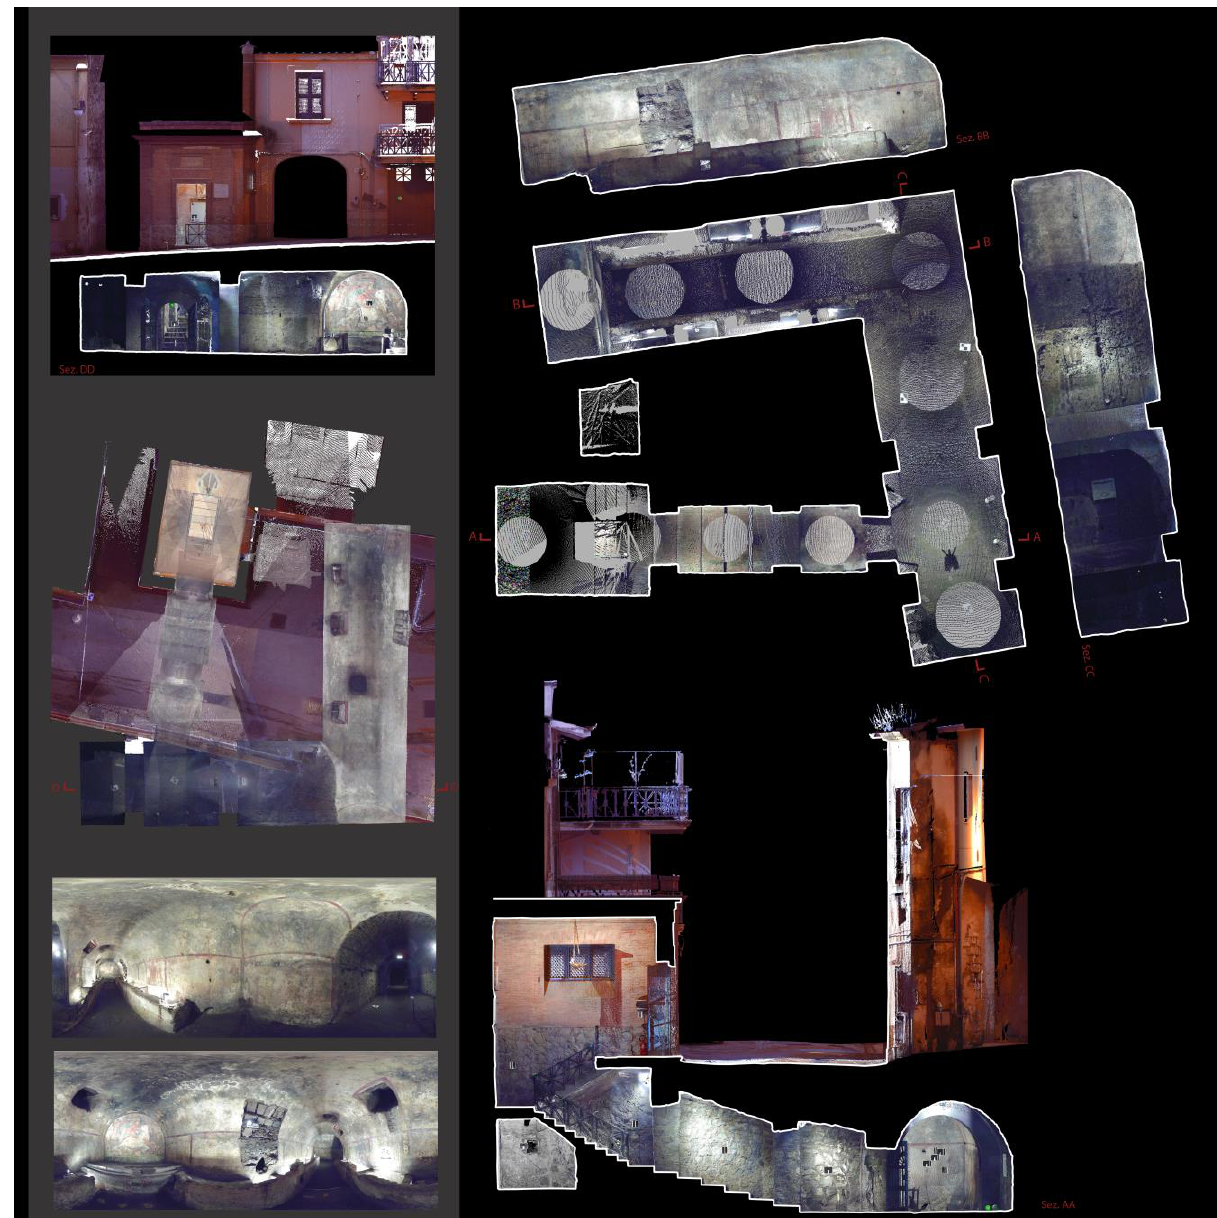
Figure 7. Orthophotos and photos spherical of the point cloud. Plans and sections